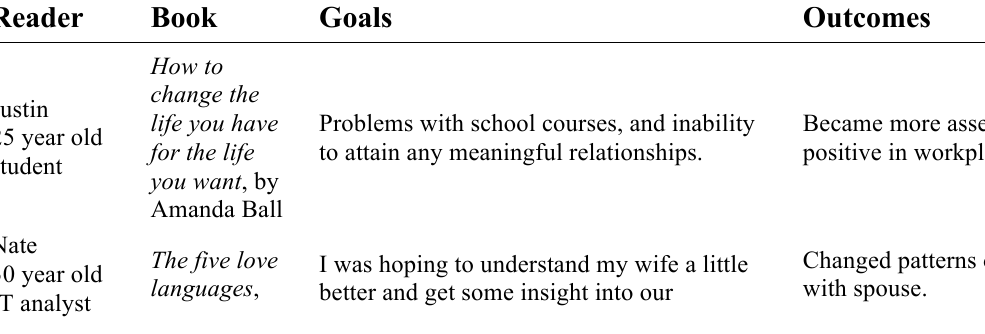
Table 7 : Male self-help reading and relationships